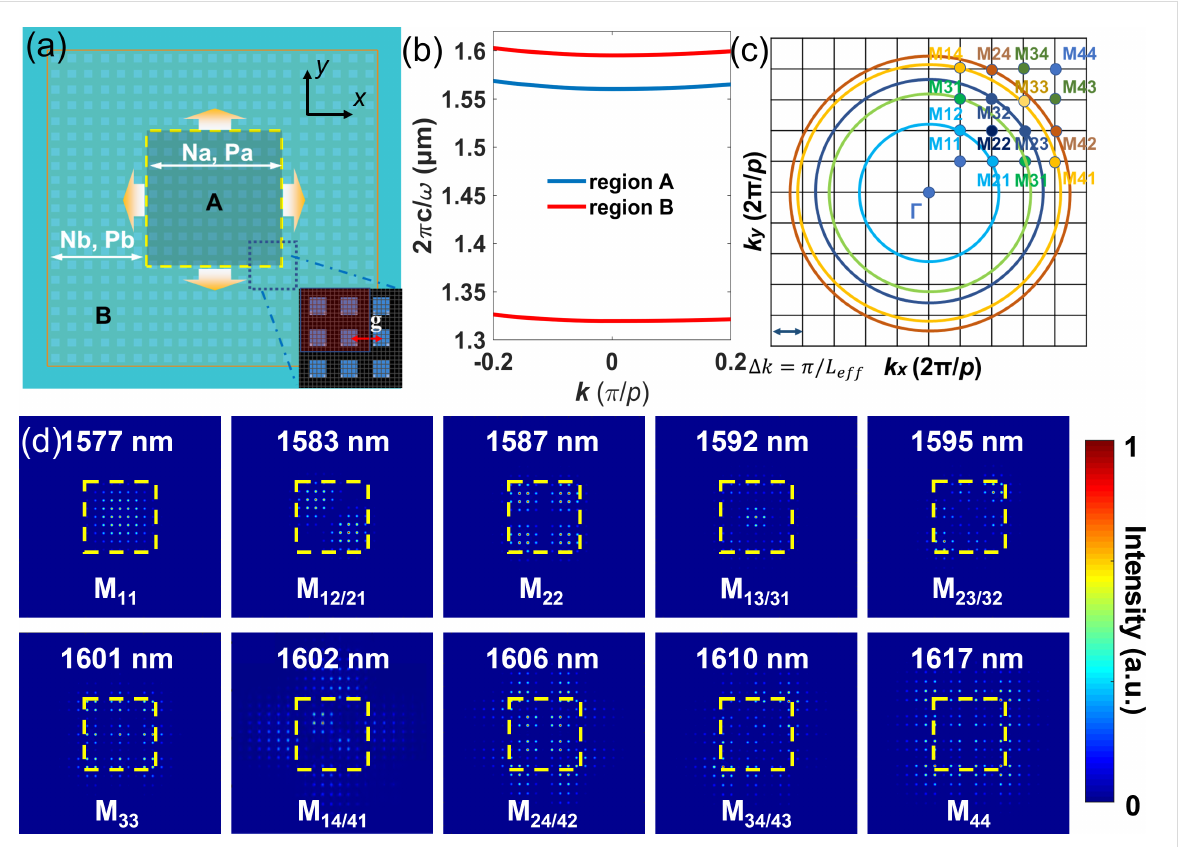
Figure 2: Design of the bandgap mirror-assisted BIC cavity. (a) Schematic of the BIC cavity surrounded by the photonic bandgap mirror. Regions A and B are the BIC cavity and the bandgap heterostructure, respectively. N a , N b , P a = p , and P b are the number of nanoblocks and lattice periods in regions A and B, respectively. Inset: the transition region at the interface between the two regions. (b) Band diagram of the structures in regions A and B. (c) The momentum distribution of all bulk modes. (d) The near-field H field intensity distribution of modes M 11 to M 44 . The yellow dashed squares indicate the boundary of region